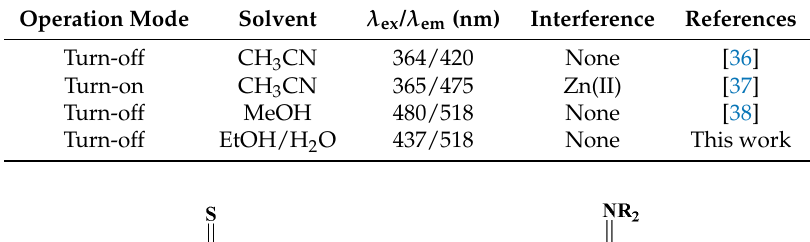
Table 1. Comparison of the recently reported sensors for the determination of Cu 2+ ions.